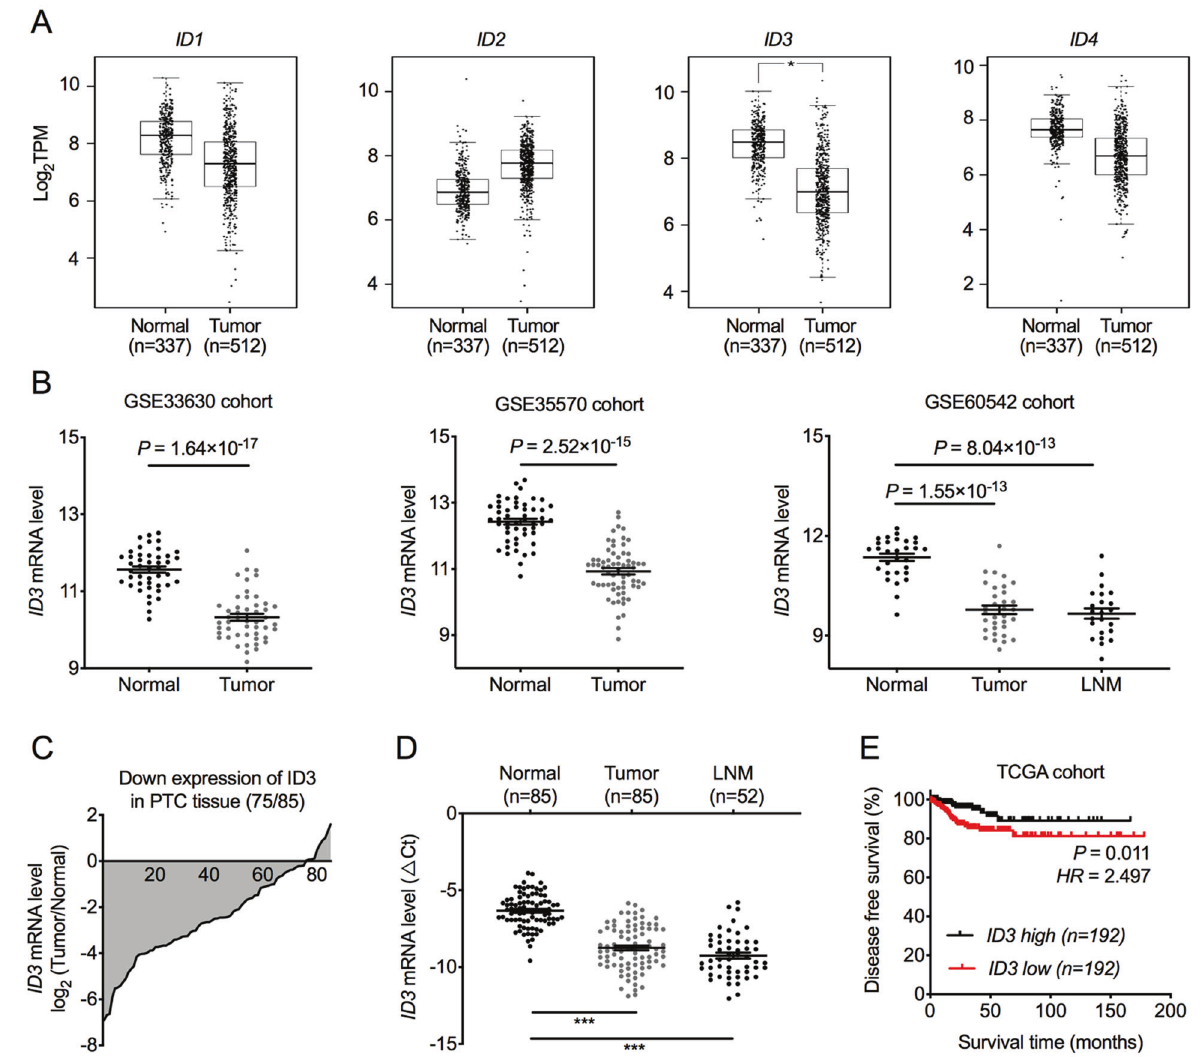
Fig. 1 ID3 is downregulated in PTC. A ID1, ID2, ID3, and ID4 mRNA levels in thyroid cancer tissues and thyroid normal tissues from the TCGA and GTEx database. * P < 0.05. B ID3 mRNA expression levels in PTC tumorous tissues, lymph node metastasis (LNM) tissues, and adjacent normal tissues in three GEO datasets, GSE33630, GSE3557, and GSE60542. C The mRNA level of ID3 was measured by real-time PCR (RT-PCR) in 85 paired PTC tissues, normalized to ACTB and expressed relative to normal tissues. D RT-PCR results showing a signi fi cant downregulation of ID3 expression in PTC tumor tissues and LNM tissues compared to paired adjacent normal tissues. Bar, SD. *** P < 0.001. E Kaplan – Meier estimate of disease-free survival times in PTC patients from TCGA database according to different ID3